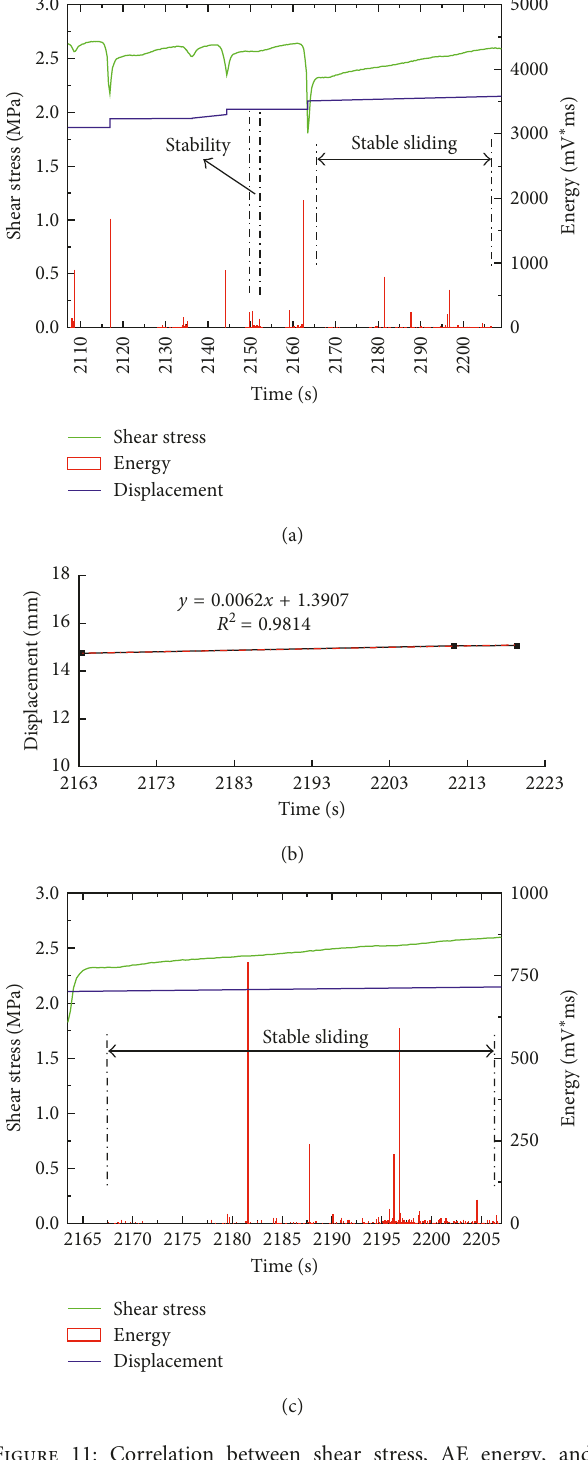
Figure 11: Correlation between shear stress, AE energy, and slipping displacement during stick-slip of Sample 4. (a) Shear stress, AE energy, and slipping displacement. (b) Slipping dis- placement curve and its linear regression. (c) Enlargement of the stable sliding stage in